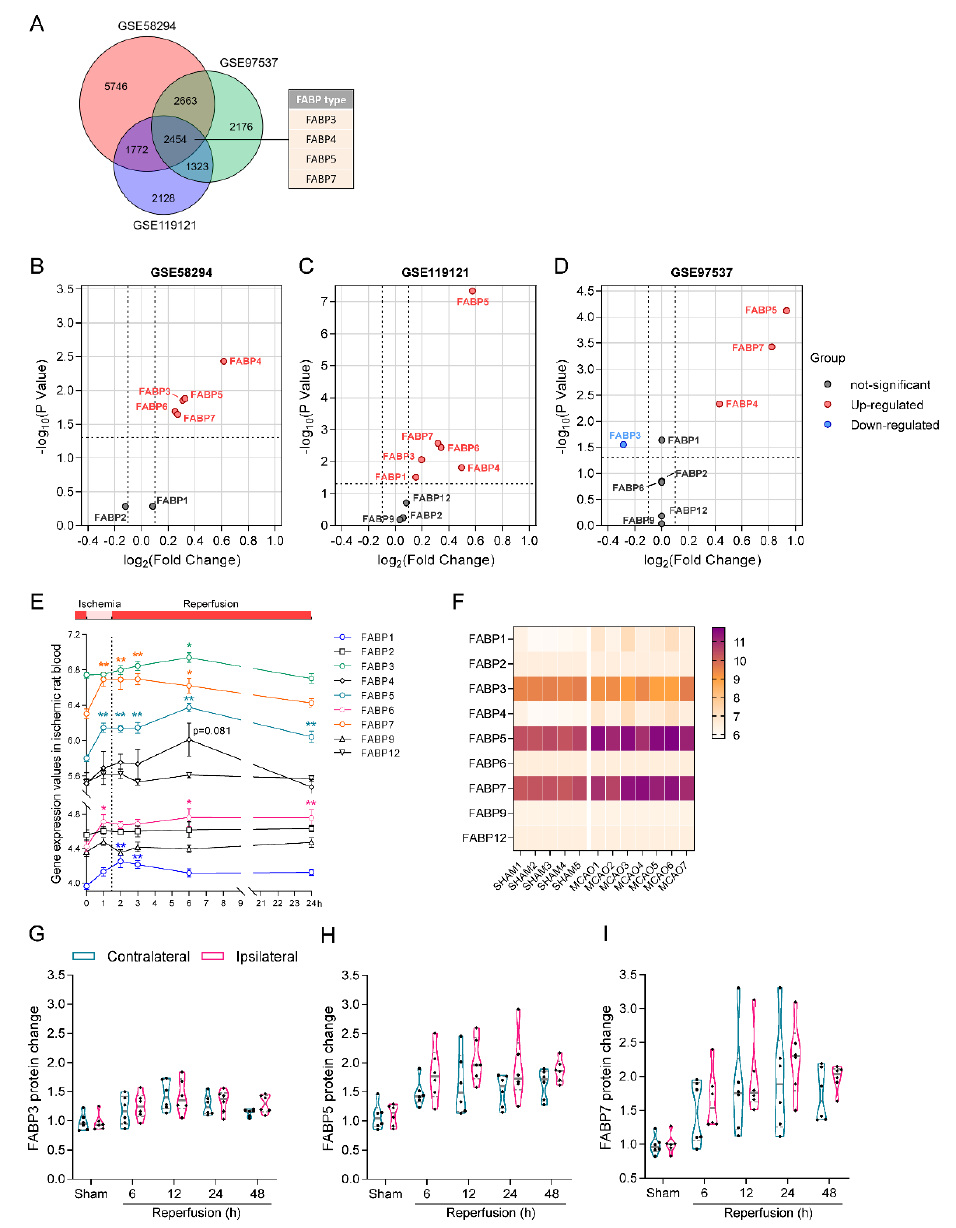
Figure 1. Differentially expressed genes (DEGs) induced by ischemic stroke. ( A ) A Venn diagram showing the overlap of DEGs among blood samples from ischemic stroke patients (GSE58294, 24 h after stroke), blood samples from MCAO rats (GSE119121, 6 h after MCAO), and brain tissue samples from MCAO rats (GSE97537, 24 h after the reperfusion). ( B – D ) Volcano plots showing p -values and log2 fold changes of gene expression for the three RNA-seq datasets in ( A ). Significant genes at p < 0.05, significantly up-regulated genes (Red dots), significantly down-regulated genes (blue dots) and non-significant genes (black dots). ( E ) FABP mRNA in whole blood was measured at 0, 1, 2, 3, 6 and 24 h after the onset of cerebral ischemia. ( n = 8 per group, GSE119121). The data shown in each case represent the mean ± SEM. * p < 0.05, ** p < 0.01 vs. 0h. (n = 8 per group) ( F ) Heatmap showing FABP gene expression levels in the brain of MCAO and sham rats 24 h after ischemia–reperfusion (GSE97537). ( G – I ) Mice received right cerebral ischemia for 2 h. Protein levels of FABPs in ischemic ipsilateral and contralateral non-ischemic brain tissue at 6, 12, 24 and 48 h after reperfusion. ( n = 6 per group).